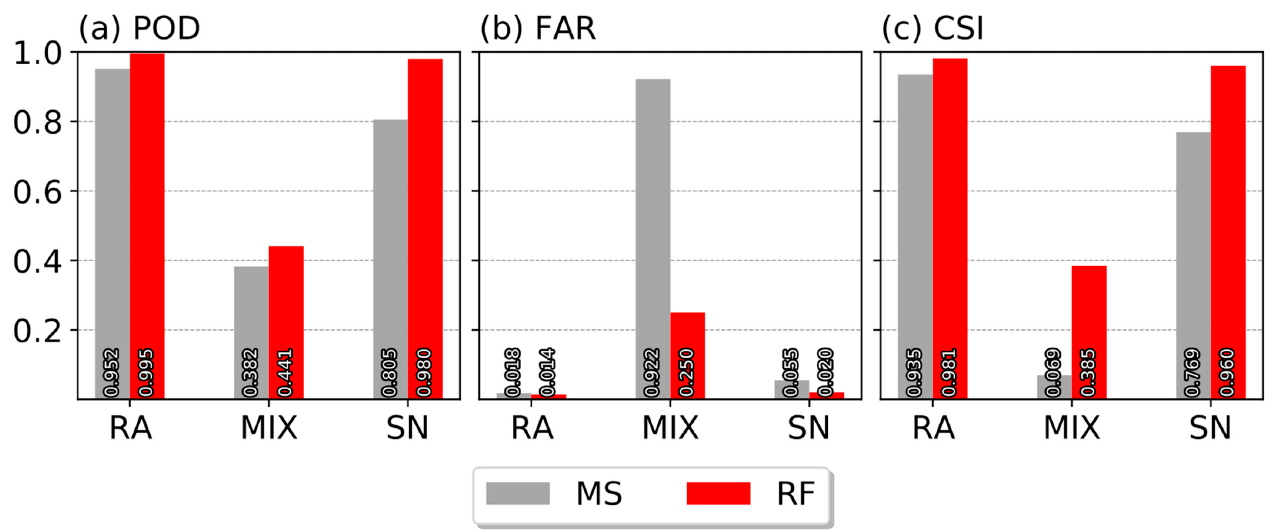
Figure 8. Same as Figure 7, but for the optimized Matsuo scheme (MS) and RF with the precipitation events.